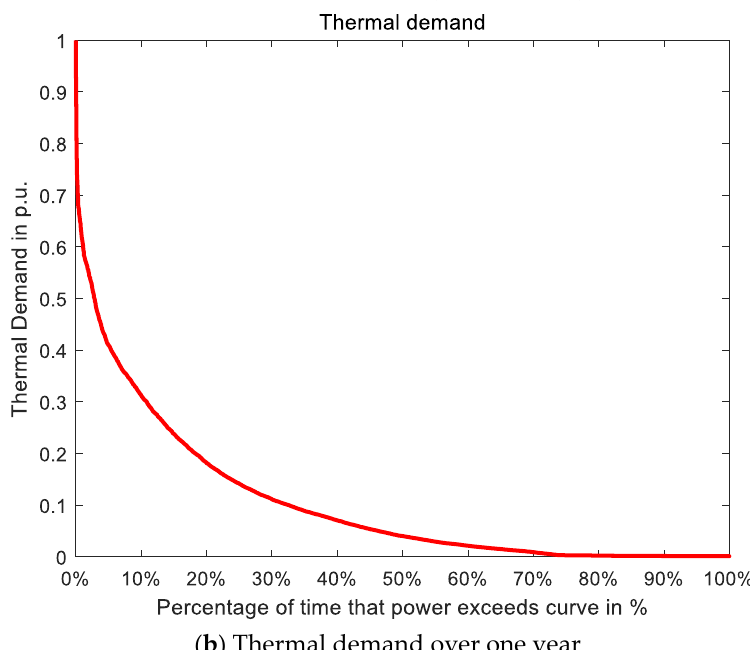
Figure 10. Thermal load profiles for the Atlanta area.